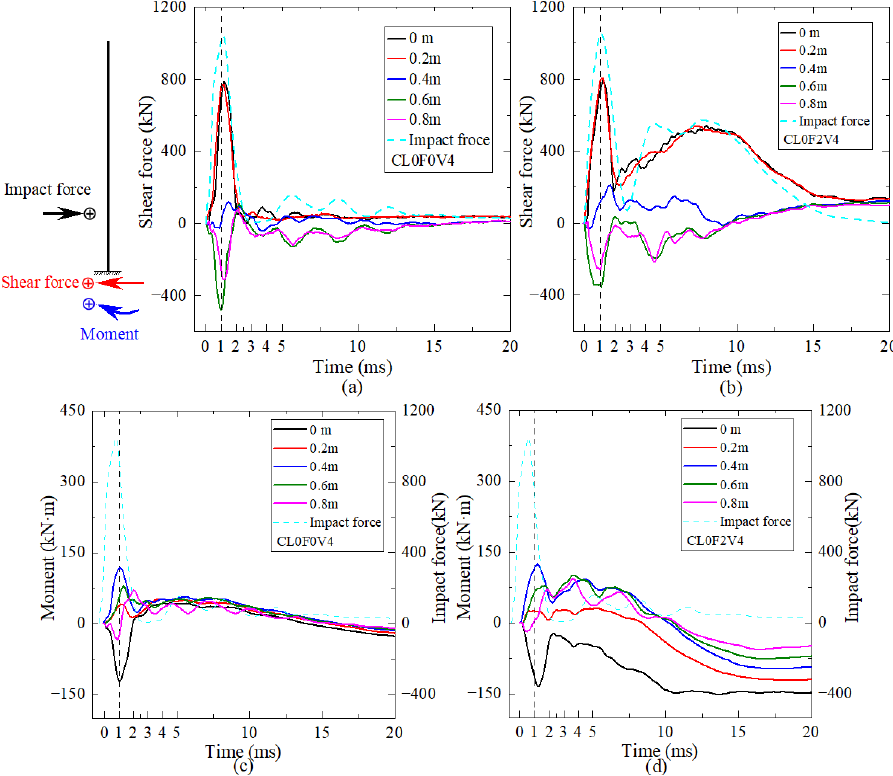
Figure 13. Time history curves: ( a ) shear force of column CL0F0V4; ( b ) shear force of column CL0F2V4; ( c ) bending moment of column CL0F0V4; ( d ) bending moment of column CL0F2V4.